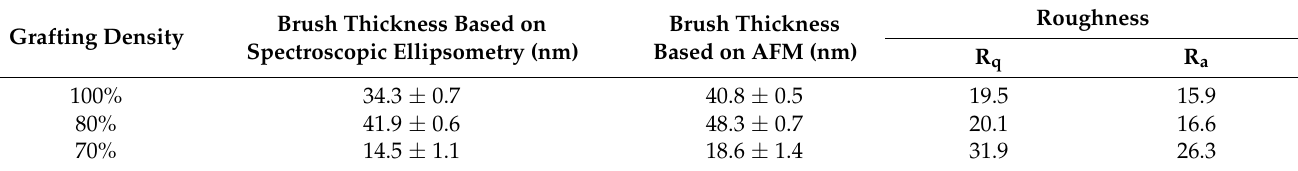
Figure 2. Relationship between the thickness of poly( St-D - alt - Ma-A ) brushes and the time of RAFT polymerization.